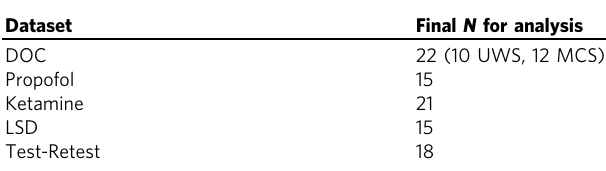
Table 2 Summary of datasets and the number of